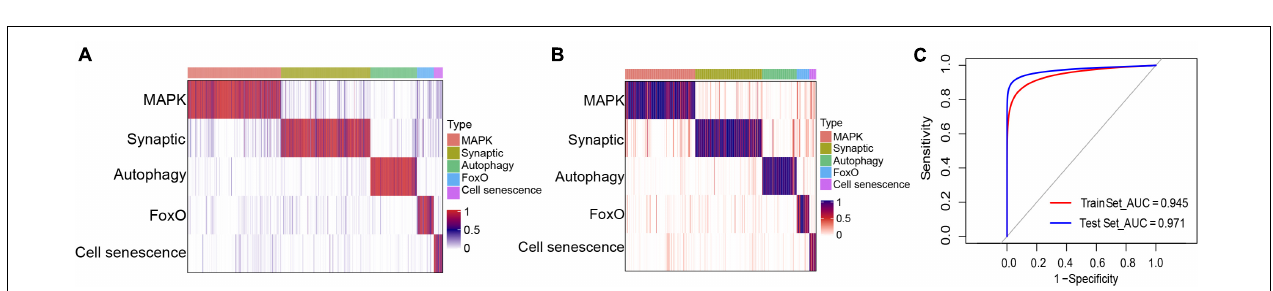
FIGURE 7 | Potential regulatory mechanism of autophagic-type Alzheimer’s disease (AD). (A) Sankey diagram showing the pathway of autophagic-type AD regulated by long non-coding RNAs (lncRNAs) and transcription factors (TFs) identified by the RNAInter and TRRUST databases. (B) Correlation pathway diagram of the gene–pathway, gene–gene, and TF–gene correlations. (C) Correlation scatter plot of the correlation between the TF HSF2 and the target gene MAPK8. (D) Potential regulatory mechanism of autophagic-type AD.